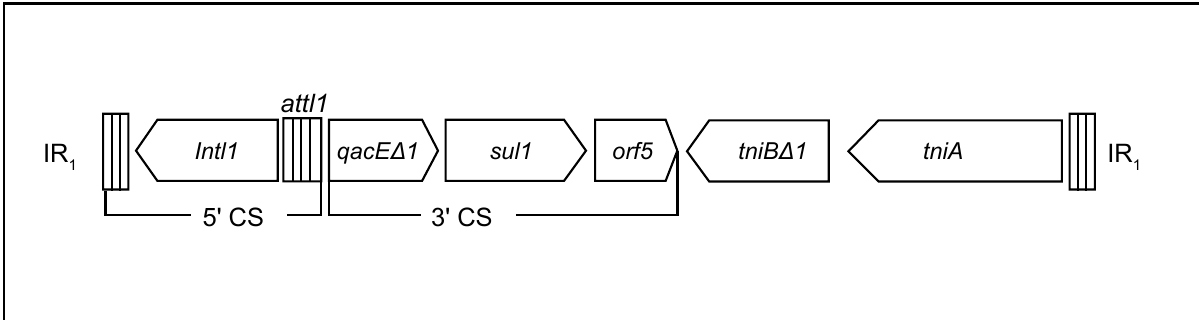
Figura 1 – Estrutura esquemática de integron de classe 1 . IR representam terminais de repetição invertidos. A região conservada 5’ consiste em intI1 e sítio de inserção attI1. A seta dos respectivos genes indica a direção de sua transcrição. A região conservada 3’ consiste nos genes qacE Δ 1, sul1 e orf5 de função desconhecida, seguidos do módulo